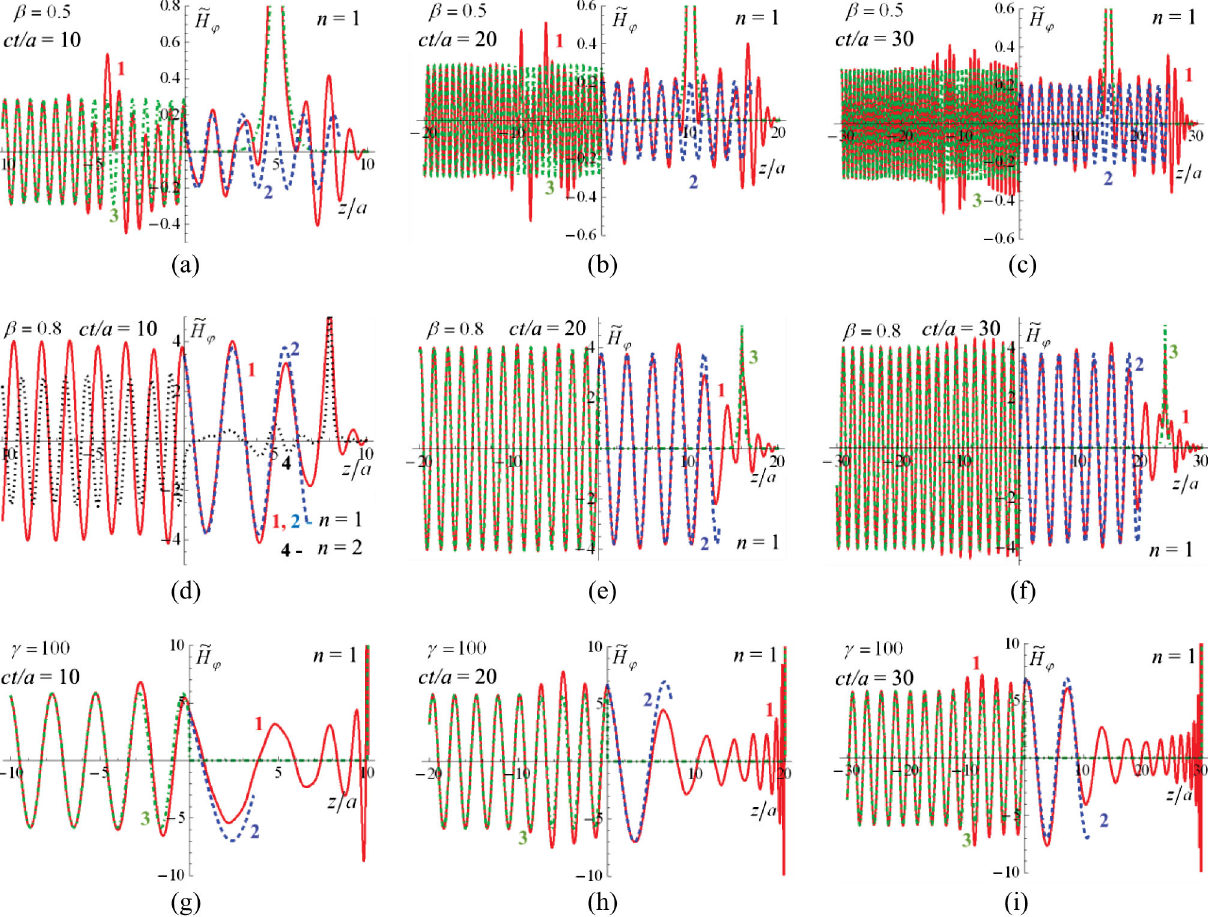
~ H 2 =q of the 1 st mode of the total field (solid red line 1 ) on the FIG. 4. Dependence of the normalized transversal component φ ¼ H φ a distance z=a at r ¼ 0 . 5 for different values of the dimensionless time ct/a and the velocity β . The dashed blue line 2 pertains to the CTR, the dot-dashed green line 3 pertains to the forced field, and the dotted black line 4 pertains to the 2 d mode of the total field (d); γ ¼ ð 1 − β 2 Þ − 1 = 2 , x 5 , ω 0 . 8 , and β 1 . 1 = ω n ¼ r ¼ p r ¼